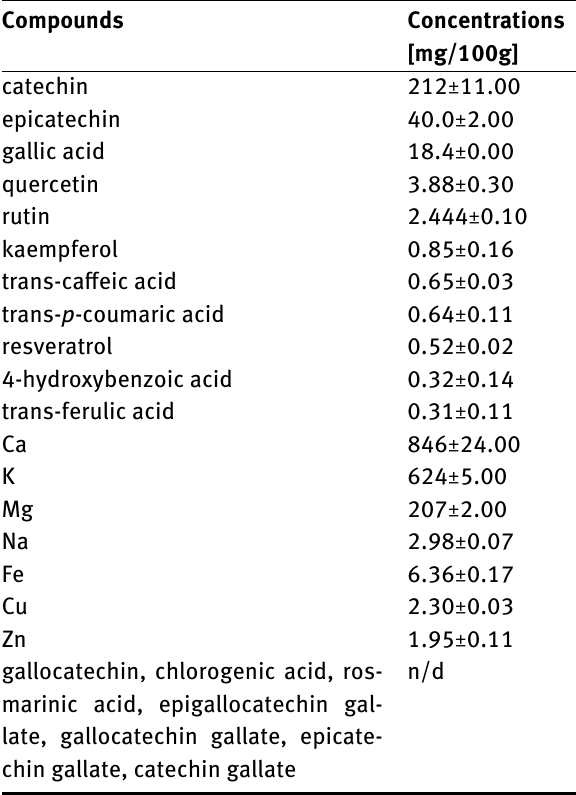
Table 1: Polyphenolic composition and mineral content in GSMP experimental sample